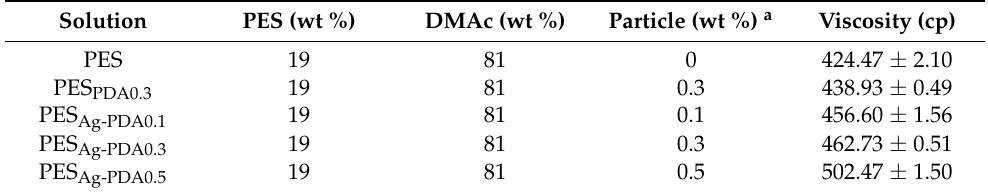
Table 1. Composition and viscosity of polymer